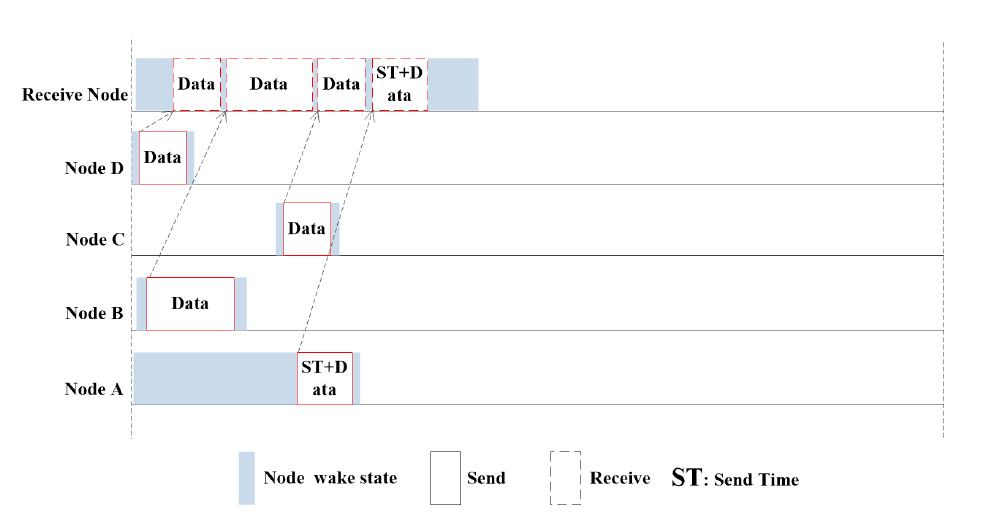
Figure 4. Data transmission